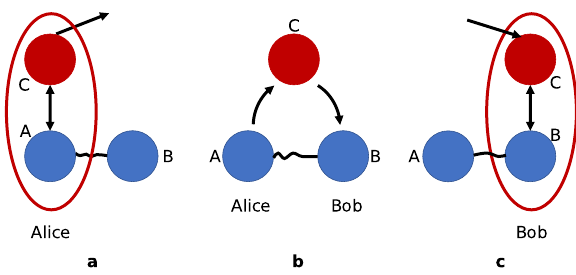
Fig. 1 Alice and Bob have particles A and B , respectively. a Alice interacts an ancilla C with her particle A . b C is then sent to Bob ’ s side. c Bob interacts C with his particle B .